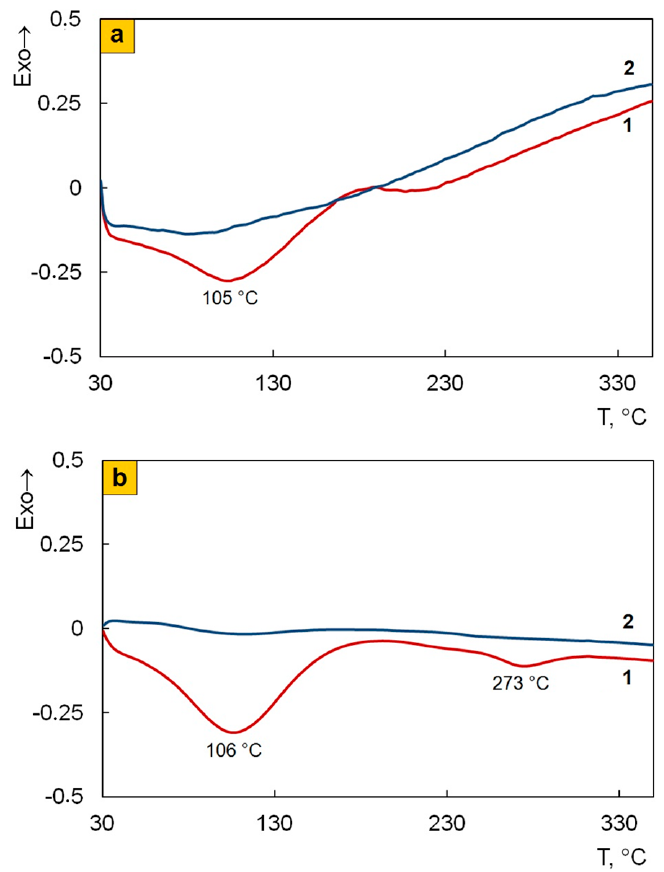
Figure 11. DSC thermograms of Fe 3 O 4 /SWCNT/PDPAC, prepared in alkaline ( a ) and acidic media ( b ), at heating in the nitrogen flow to 350 ◦ C ( 1 —first heating, 2 —second heating).